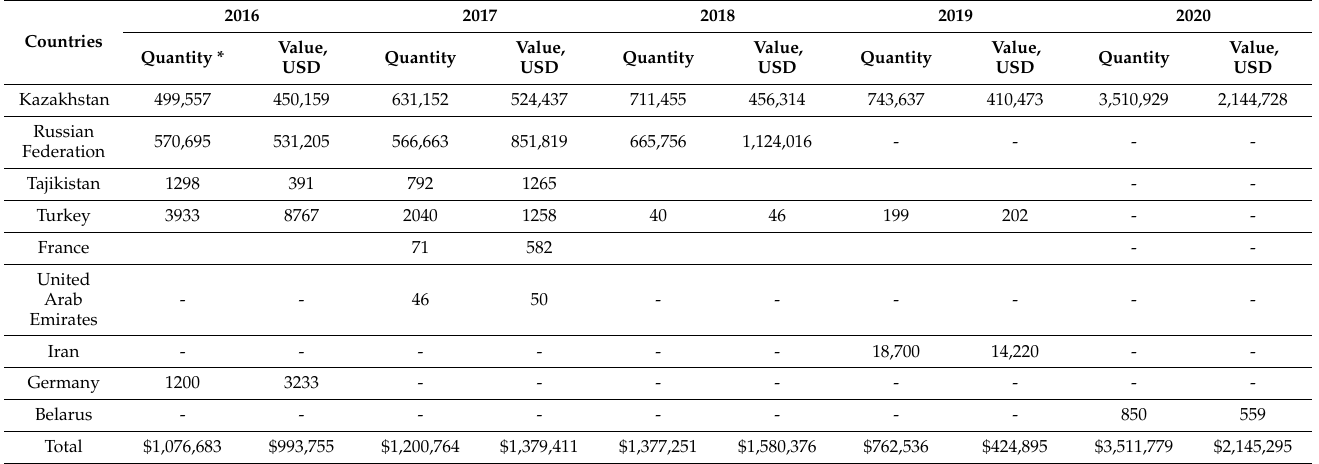
Figure 2. Export value of milk and dairy products from Kyrgyzstan from 2016 to 2020. Adapted from www.stat.kg, accessed on 11 January 2022 [20]. Table 3. Import value of milk and dairy products (milk and cream: not concentrated, not containing added sugar or other sweetening matter (FEACN code 0401)) to Kyrgyzstan from 2016 to 2020 (Quantity * in tons of milk and dairy products). Adapted from www.comtrade.un.org, accessed on 3 January 2022